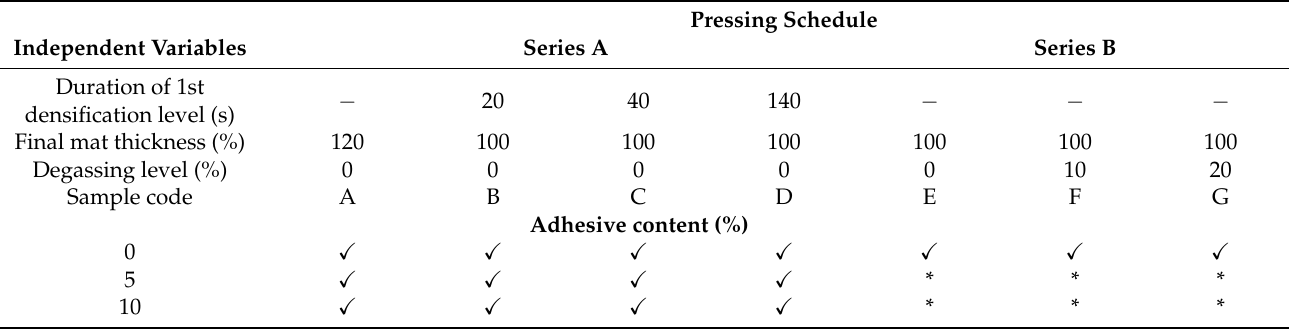
Table 1. Protocols used for panels